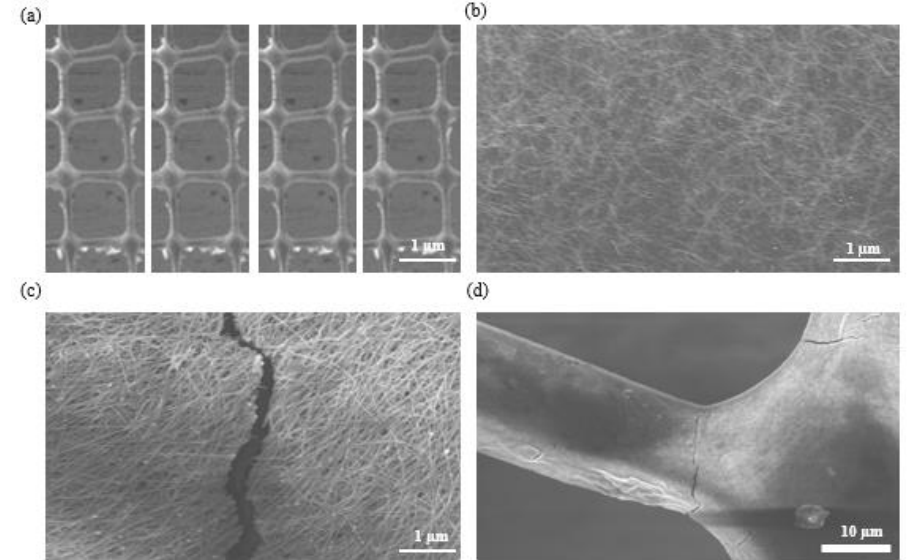
Figure 3. SEM analysis images. ( a ) Mesh printing structure, ( b ) uniform coating of AgNWs on the printed structure, ( c , d ) cracks in the coating after multiple strain tests.